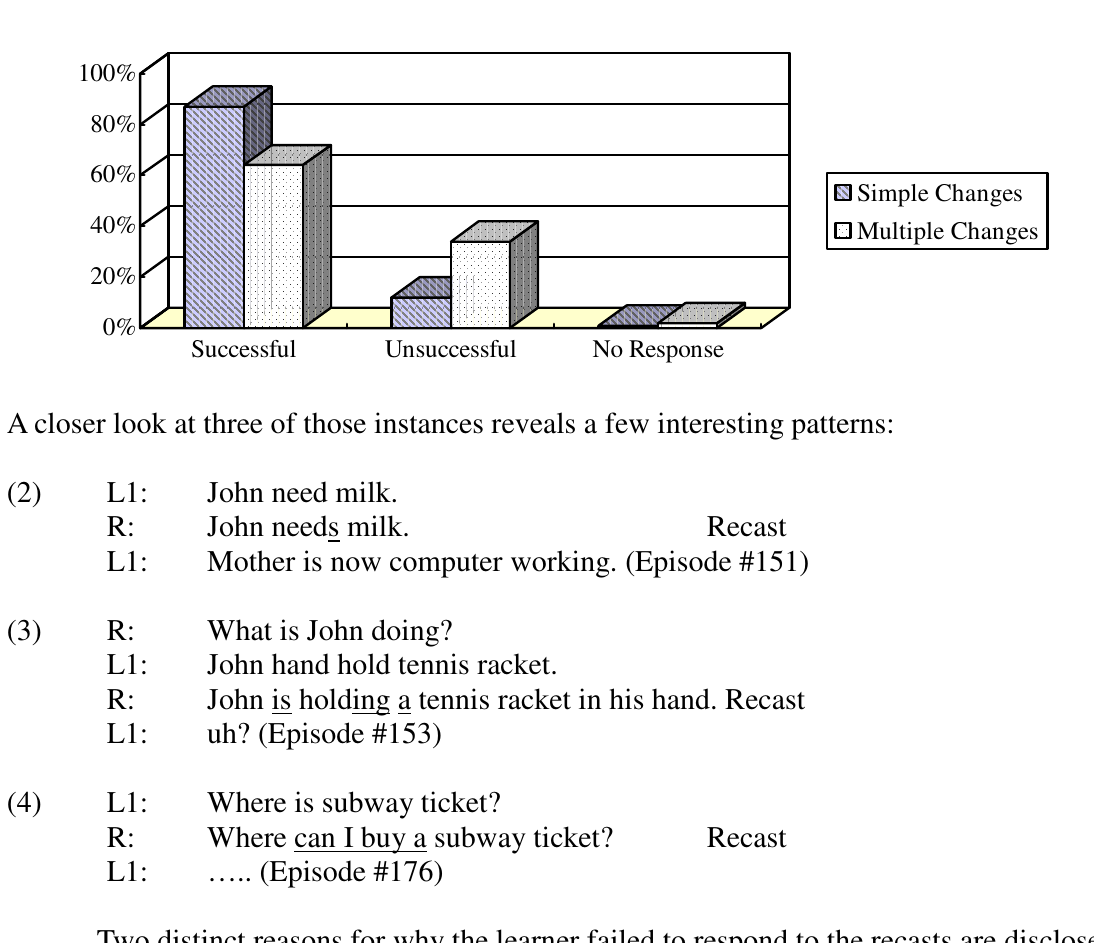
Number of Changes and Learner